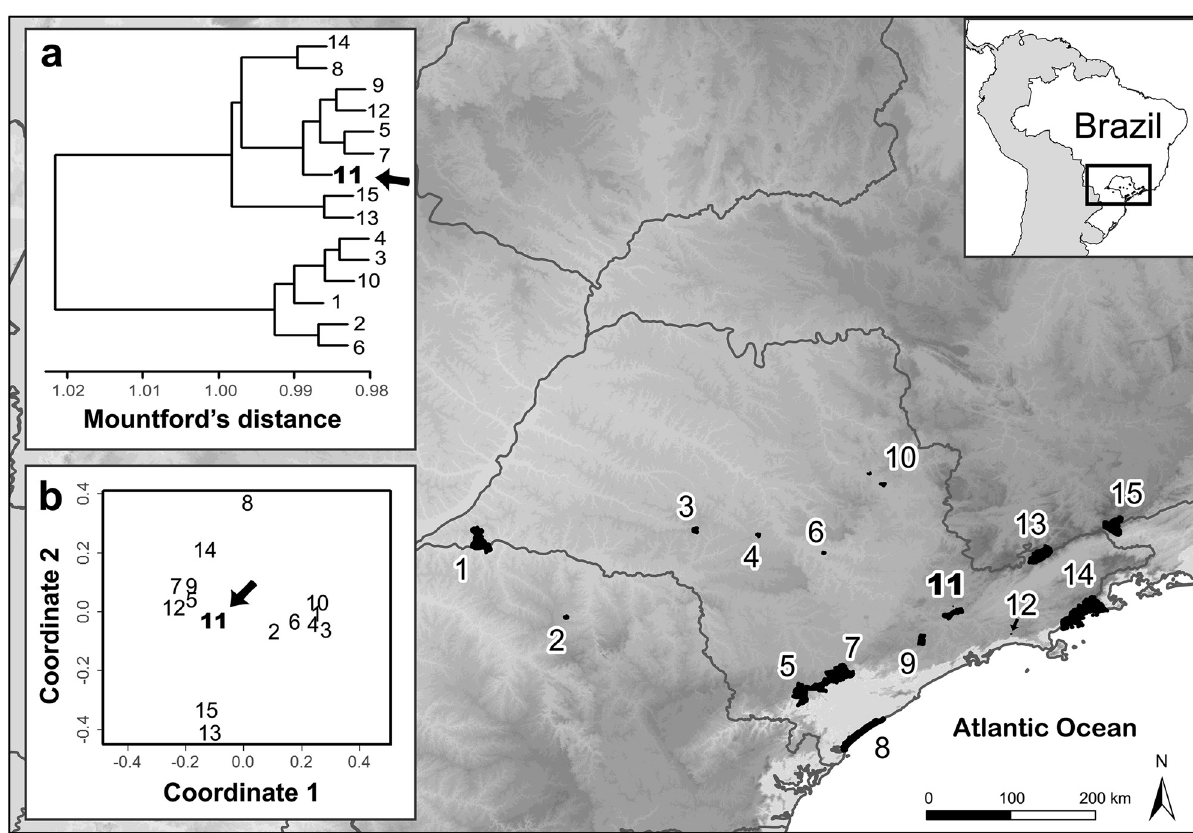
Figure 2. Dendogram with Atlantic Forest regions based on their bird community using Hierarchical Cluster Analysis (Mountford’s distance coefficient; a) and the Principal Coordinate Analysis of these areas (b). 1 = Morro do Diabo State Park; 2 = Mata dos Godoy State Park; 3 = Caetetus Ecological Station; 4 = Rio Claro Farm; 5 = Intervales State Park; 6 = Barreiro Rico Ecological Station; 7 = Carlos Botelho State Park; 8 = Ilha Comprida; 9 = Morro Grande Reserve; 10 = Porto Ferreira (Porto Ferreira and Vassununga State Parks); 11 = Serra da Cantareira; 12 = Boracéia Biological Station; 13 = Campos do Jordão (composed by Mananciais de Campos do Jordão and Campos do Jordão State Parks); 14 = Ubatuba; 15 = Itatiaia National